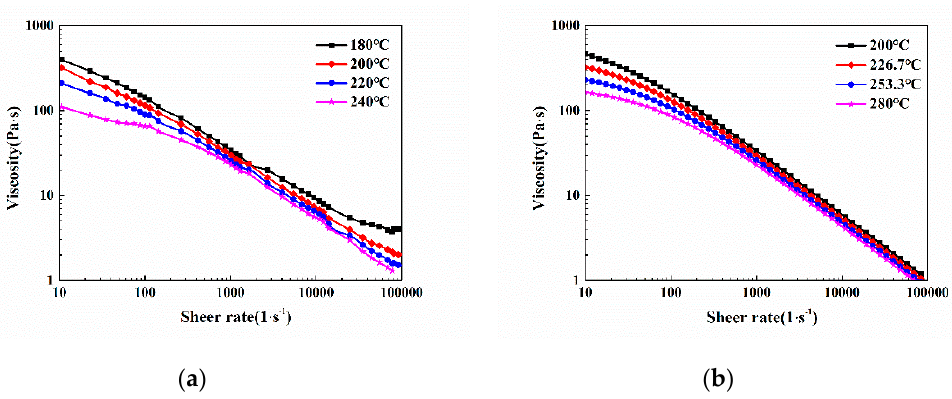
Figure 4. Viscosity property of modified PP: ( a ) viscosity curve of modified PP; ( b ) fitted viscosity curve of modified PP.